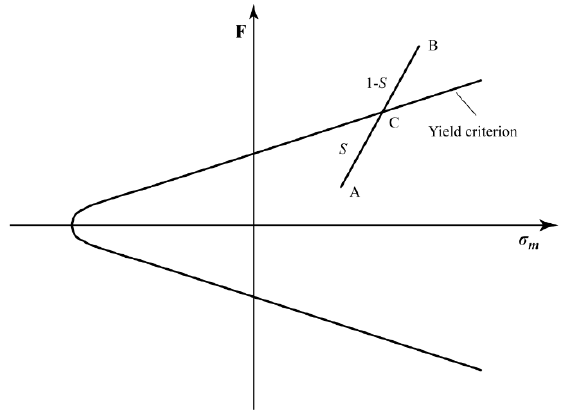
Figure 2. Stress state in the excavation load release process.